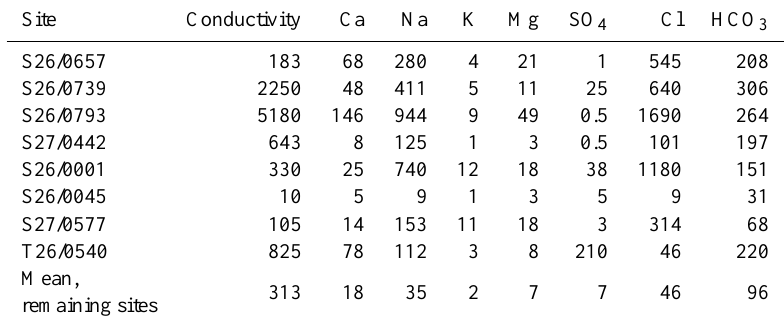
Table 1. Median values of chemical parameters for the eight outlier sites (µScm − 1 for conductivity, mgl − 1 for other parameters). Mean of site-specific median values from the remaining 268 monitoring sites are presented for comparison. Site Conductivity Ca